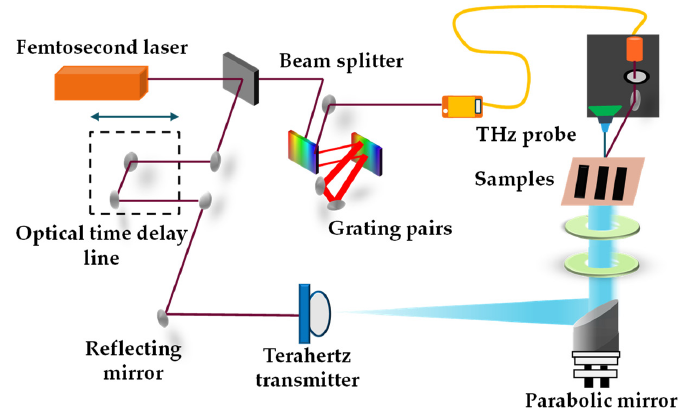
Figure 17. Terahertz imaging schematic.